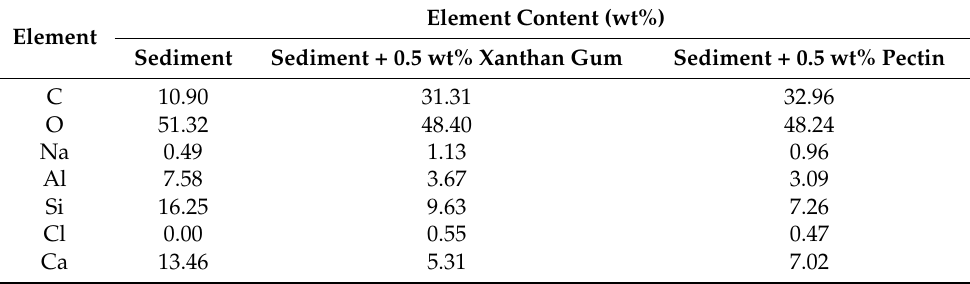
Figure 10. EDS elemental mapping of filter cakes of gel – sediment solutions: ( a ) sediments; ( b ) sedi- ments + 0.5 wt% xanthan gum; ( c ) sediments + 0.5 wt% pectin.